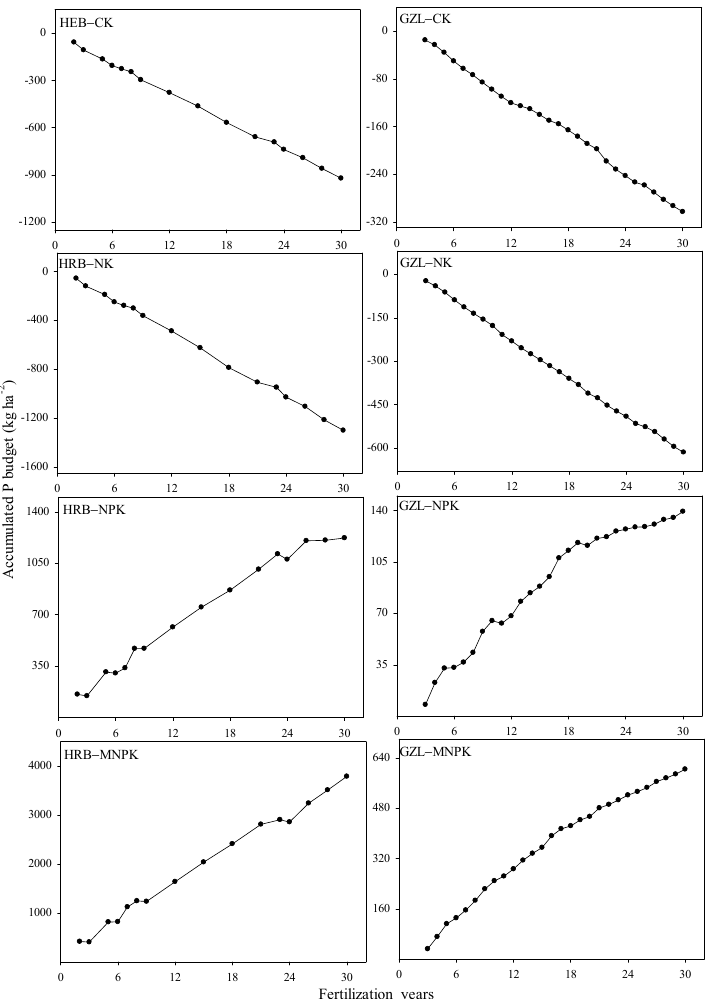
Figure 2. Accumulated of P budget at two fertilization sites. HRB and GZL are the abbreviations of the names of the long-term experiment sites, which are located in Harbin and Gongzhuling in China. CK, no fertilizer or manure; NK, nitrogen and potassium; NPK, nitrogen, phosphorus and potassium; MNPK, manure, nitrogen, phosphorus and potassium. The fitting equations between Δ Olsen P and budget of P for the three treatments (NK, NPK and MNPK) at the two long-term experiments were analyzed (Figure 3). With the same fertilization treatment, the fitting curves of Δ Olsen P and P budget were similar at two long-term experiments. Applying phosphate fertilizer (NPK and MNPK) can